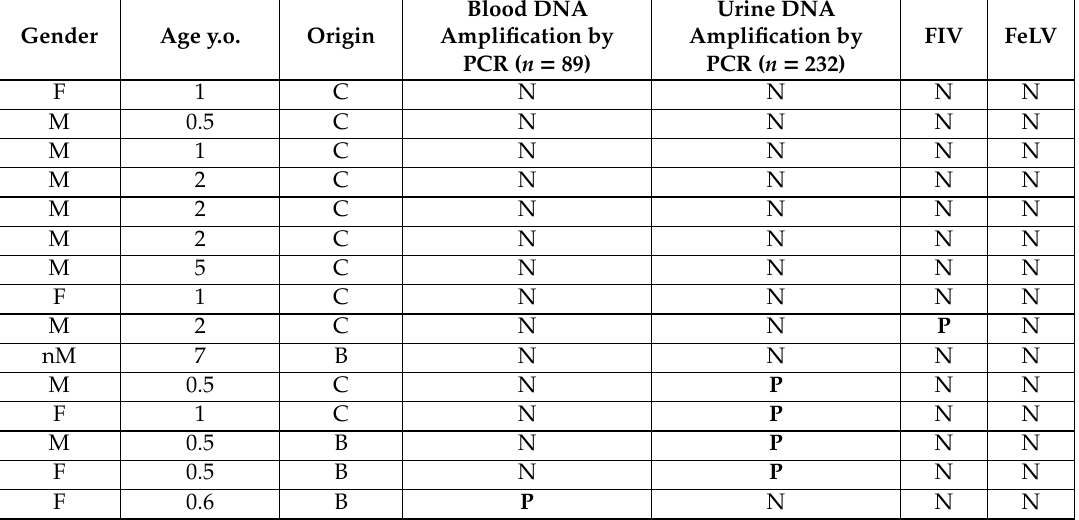
Table 4. Results of DNA detection in blood and urinary shedding by polymerase chain reaction (PCR) in cats from Spain. Gender Age y.o. Origin